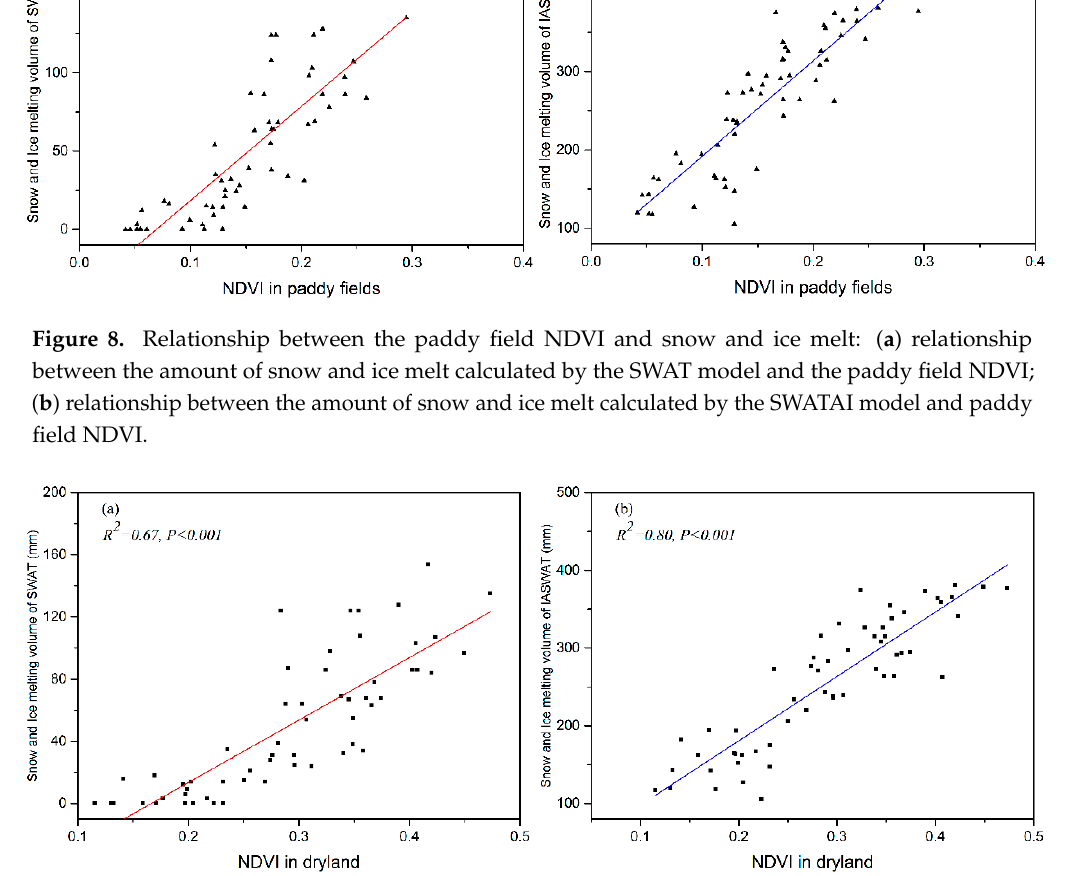
Figure 9. Relationship between the dry land NDVI and snow and ice melt: ( a ) relationship between the amount of snow and ice melt calculated by the SWAT model and the dry land NDVI; ( b ) relationship between the amount of snow and ice melt calculated by the SWATAI model and the dry land NDVI.